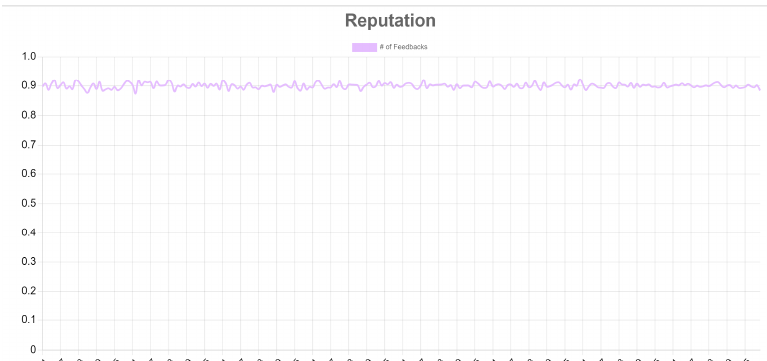
Figure 6. Reputation Chart for SP3.